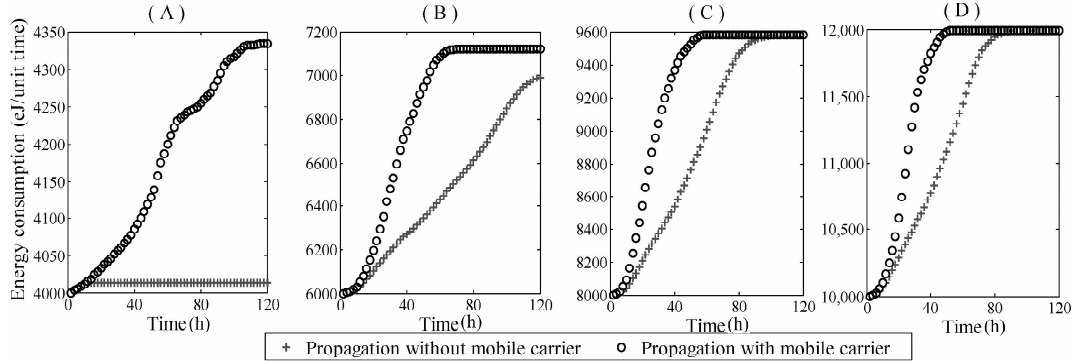
Figure 8. Network energy consumption vs. Propagation time (The network sizes of ( A – D ) are 4000, 6000, 8000, and 10,000, respectively).